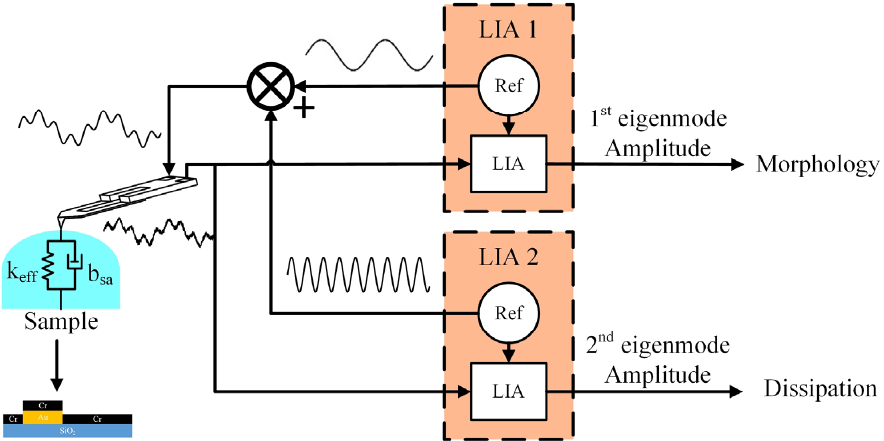
Figure 15. The Schematic of bimodal AFM based on an Akiyama probe.